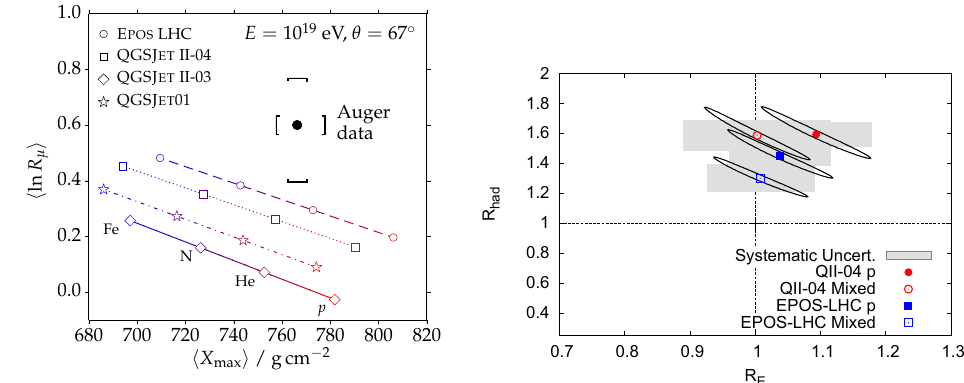
Figure 2. (cid:2) ln A (cid:3) as a function of the energy. The results obtained with the Delta method (filled squares and filled circles) are compared to the values of X max measured by the FD (open squares) [4].